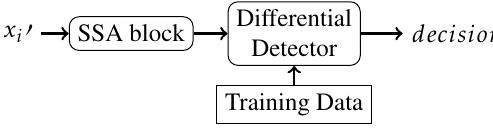
Figure 8. Offline Detector Structure.